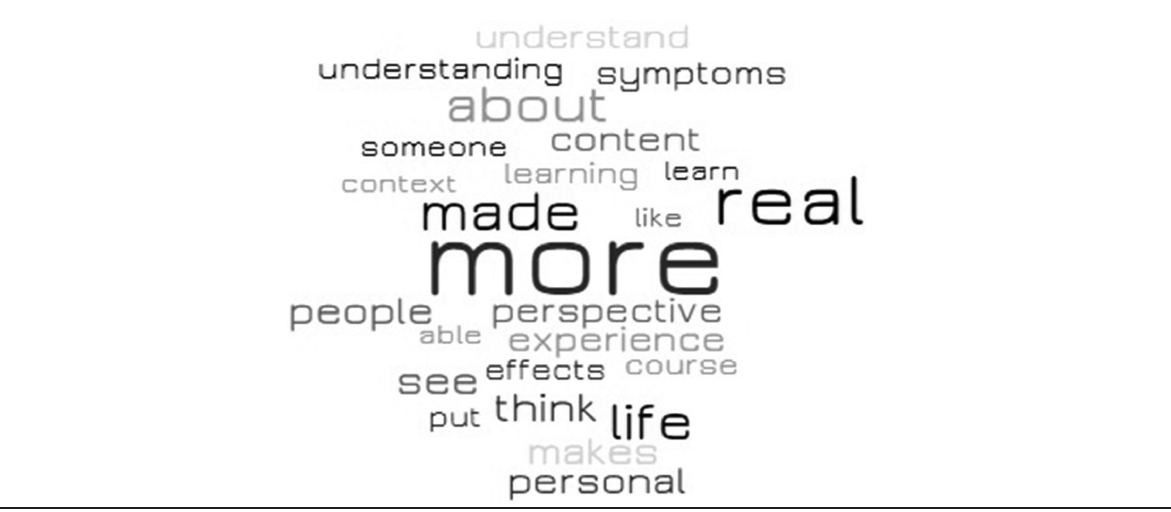
Figure 3. Word cloud generated from open student comments about Matthew’s contribution to Ellen’s undergraduate lectures on the control of movement. The words ‘Parkinson’s’, ‘disease(s)’ and ‘lecture(s)’ were removed (Source: Authors,